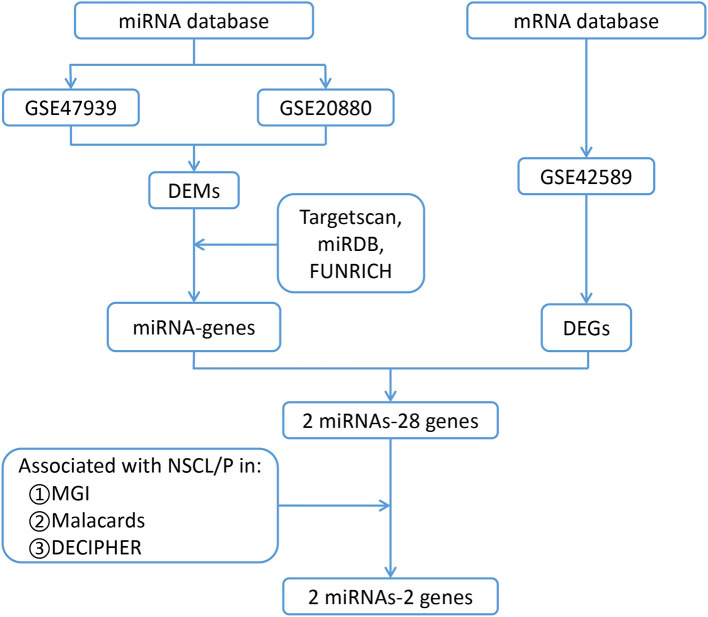
Flow chart for identification of the two miRNAs and their two target genes that are associated with non-syndromic orofacial clefts. DEMs, differentially expressed microRNAs; DEGs, differentially expressed genes; NSCL/P, Non-syndromic cleft lip with or without palate; GSE47939, contained 10 non-syndromic cleft palate patients and six controls; GSE20880, three murine embryonic orofacial tissues on gestational days 12–14; GSE42589, included seven NSCL/P samples and six control samples; MGI, Mouse Genome Informatics database; MalaCards, A Comprehensive Automatically-Mined Database of Human Diseases; DECIPHER, DatabasE of genomiC varIation and Phenotype in Humans using Ensembl Resources, Targetscan, predicts biological targets of miRNAs by searching for the presence of conserved 8mer, 7mer, and 6mer sites that match the seed region of each miRNA (http://www.targetscan.org/vert_72/); miRDB, MicroRNA Target Prediction Database (http://mirdb.org/); FUNRICH, Functional Enrichment analysis tool (http://www.funrich.org software).